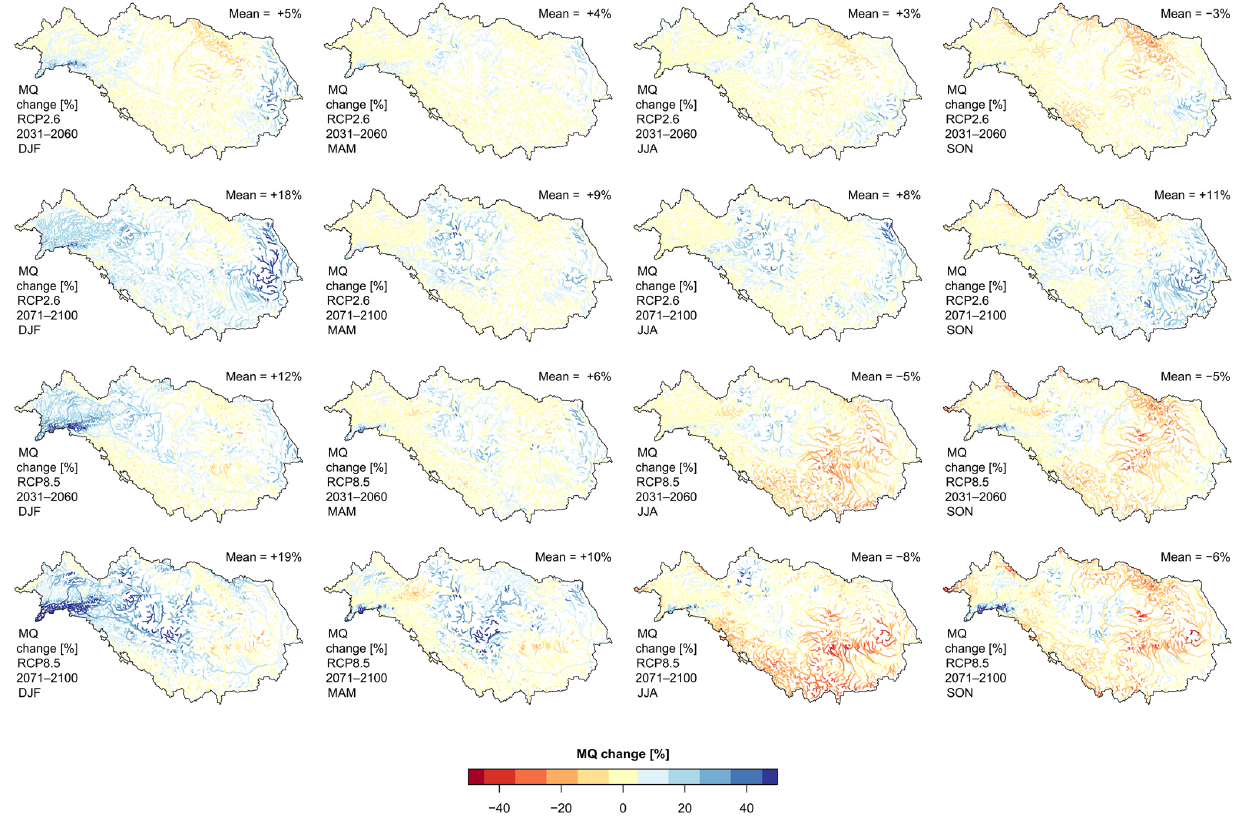
Figure 13. Maps of the long-term mean seasonal MQ change [%] in the Danube River Basin according to the GCM-RCM-driven simulations (ensemble mean) under RCP2.6 and RCP8.5 for the near